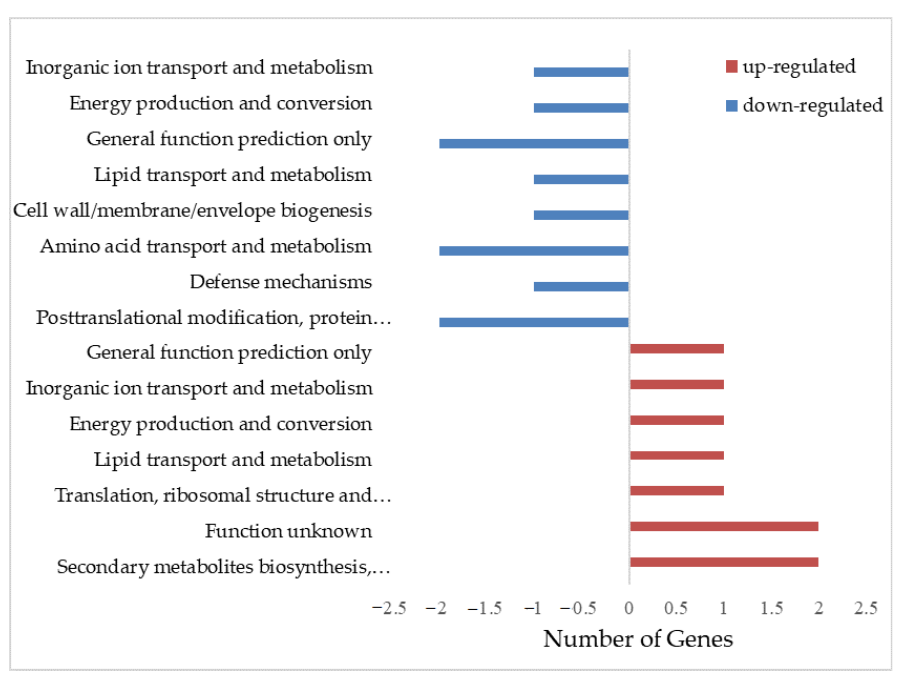
Figure 2. Cluster of orthologous genes (COG) classification of differentially expressed genes.